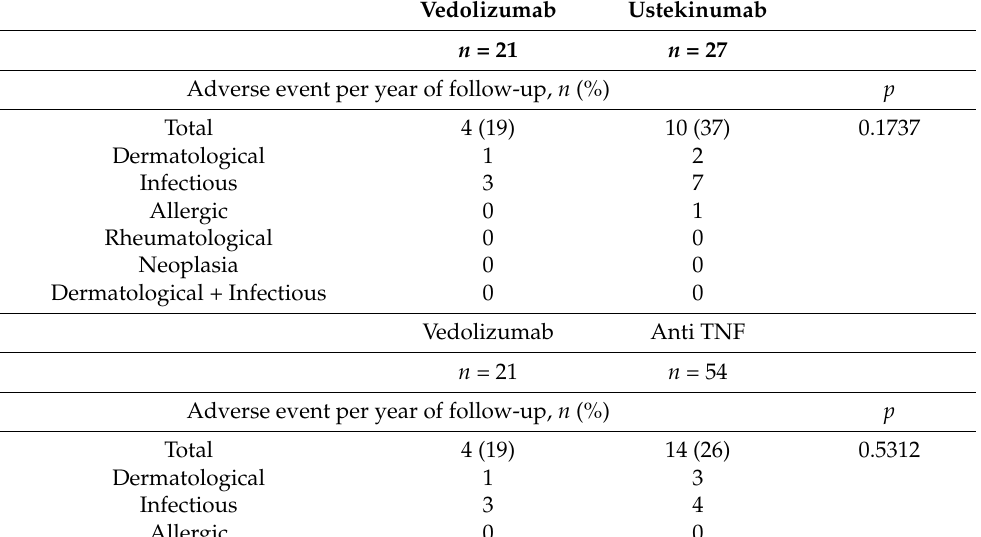
Table 4. Comparative safety in patients with Crohn’s disease treated with vedolizumab, ustekinumab or anti-TNF